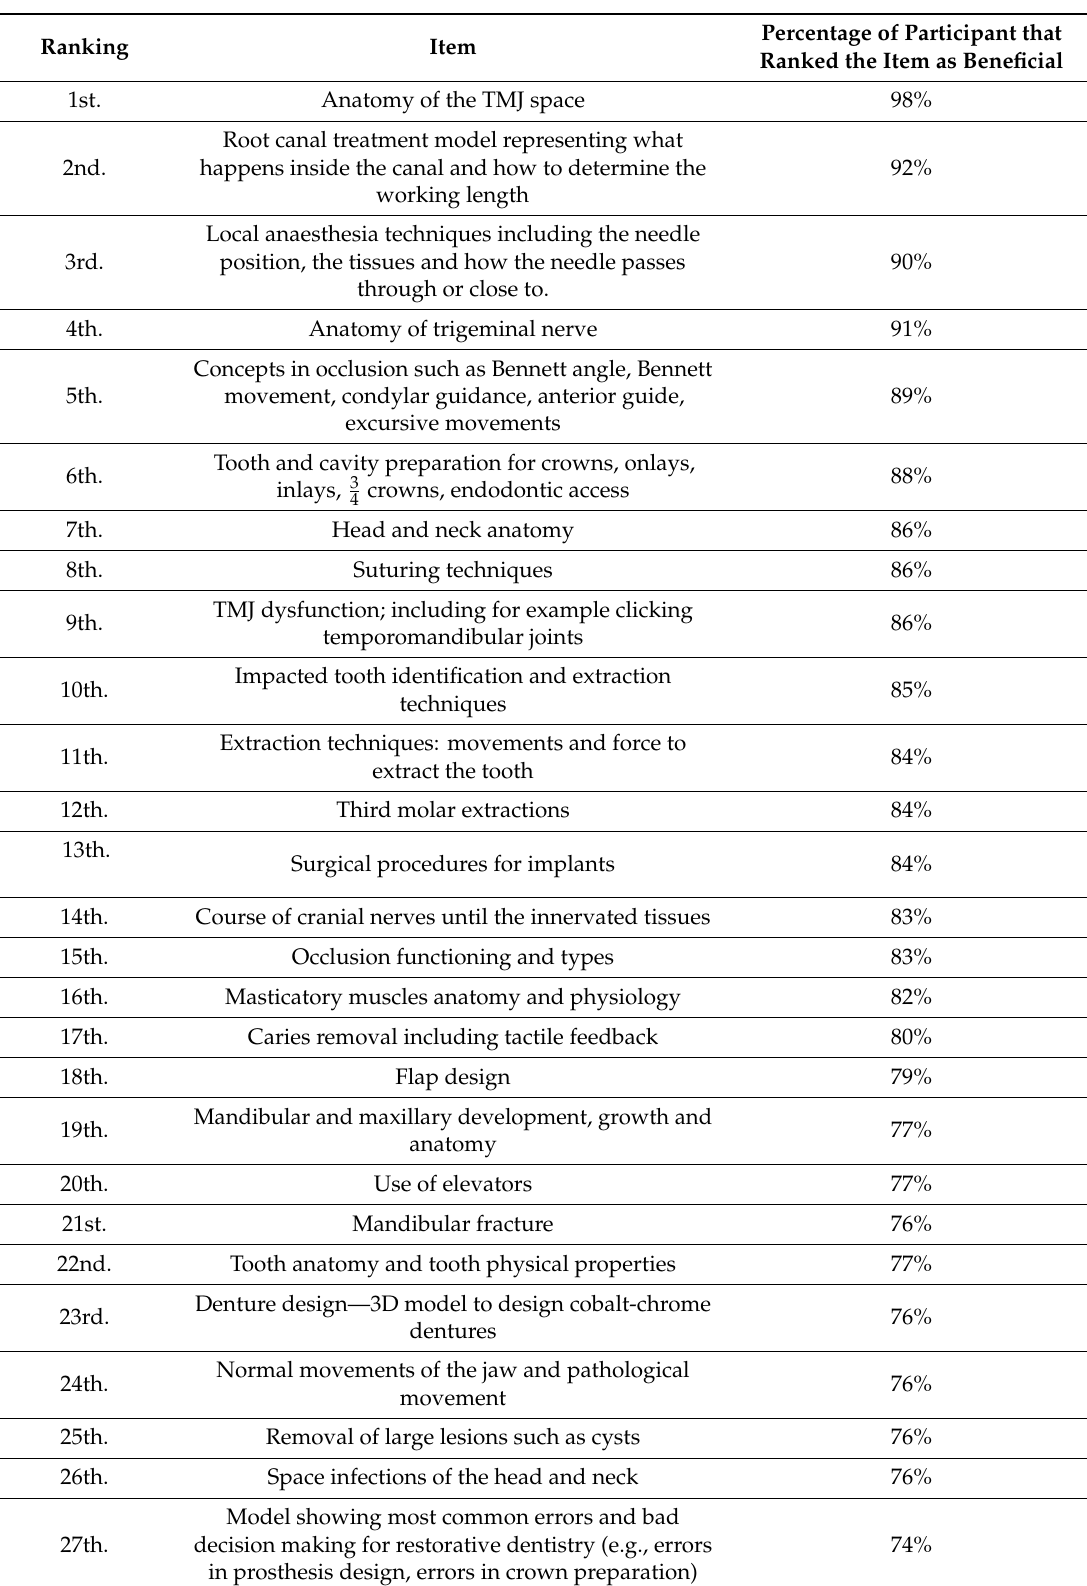
Table 2. Ranking of the perceived need for a 3D learning resource for dental education.